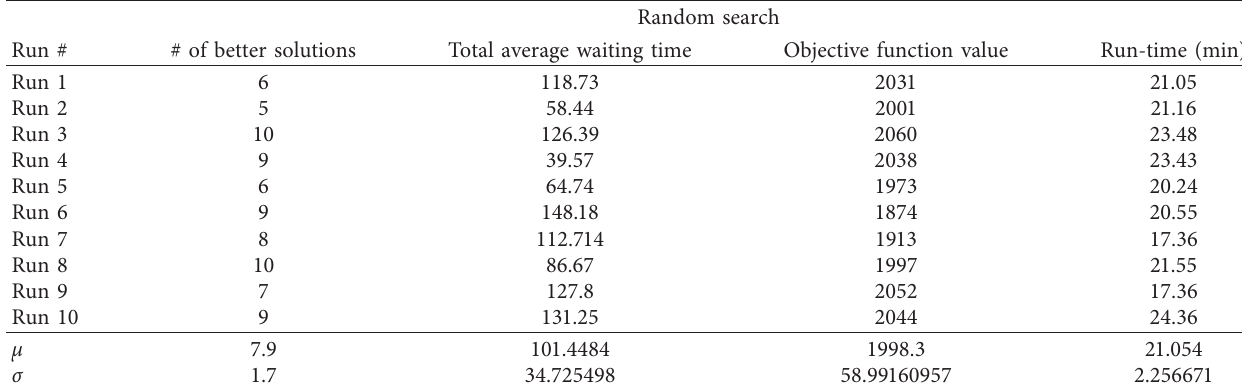
Table 2: Summary of simulated annealing results using random search